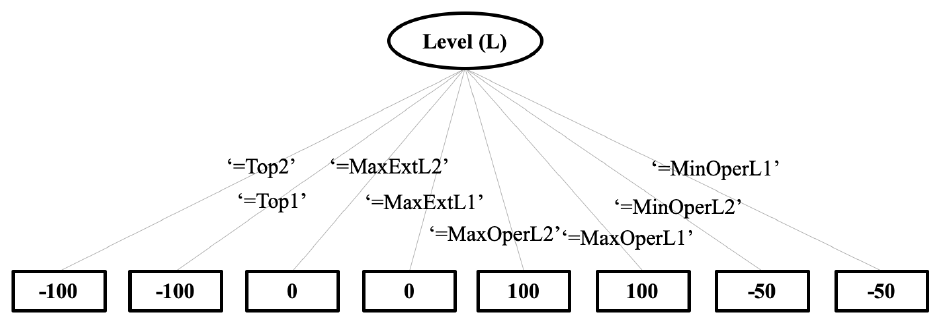
Figure 3. The reward function is represented as a decision tree. Dam levels of MaxOperL1 or MaxOperL2 are rewarded 100 economic units (best case). MaxExtL1 or MaxExtL2 levels receive a reward of 0 (irrelevant). Top1 or Top2 levels are penalized by ´ 100 (worst case). Level MinOperL receives a reward of ´ 50 (bad).